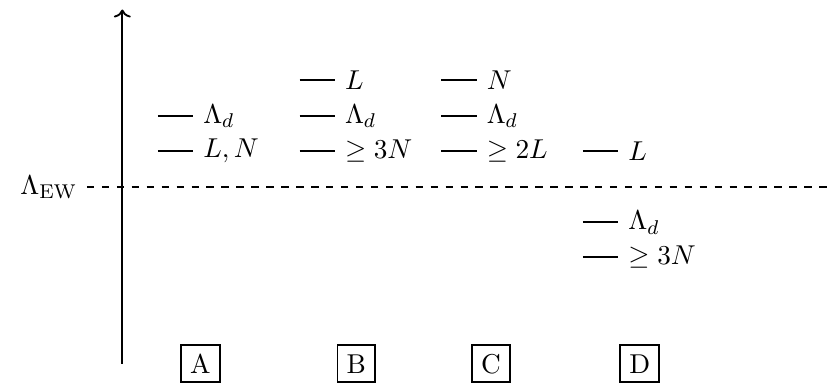
Figure 6. Summary of the models that can generate the back-reaction for the relaxion mechanism to work and, at the same time, satisfy the Pisarski-Wilczek condition. We show only variations of the L + N model defined in section A.2, although more general possibilities are